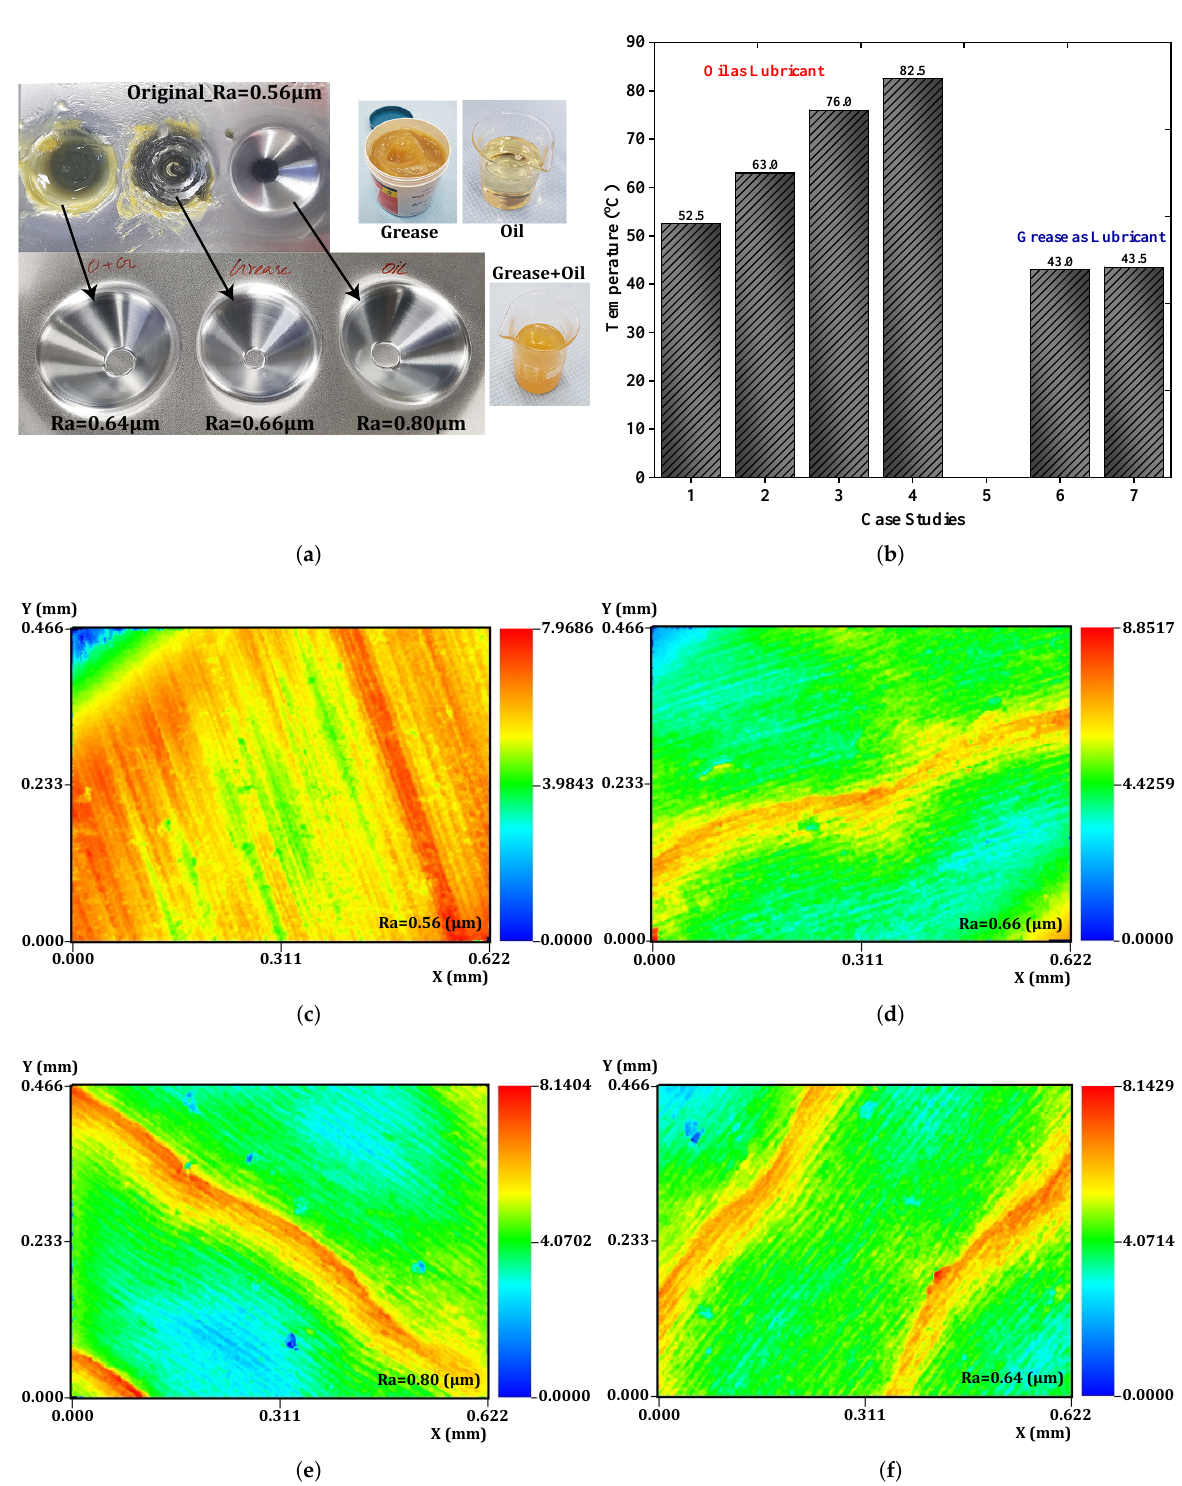
Figure 4. ( a ) Assessment of lubricants; ( b ) temperature comparison plot; 2D surface roughness profile of the formed material using different lubricants from the 3D nano profiler: ( c ) original surface; ( d ) grease; ( e ) oil; ( f ) combination of oil and